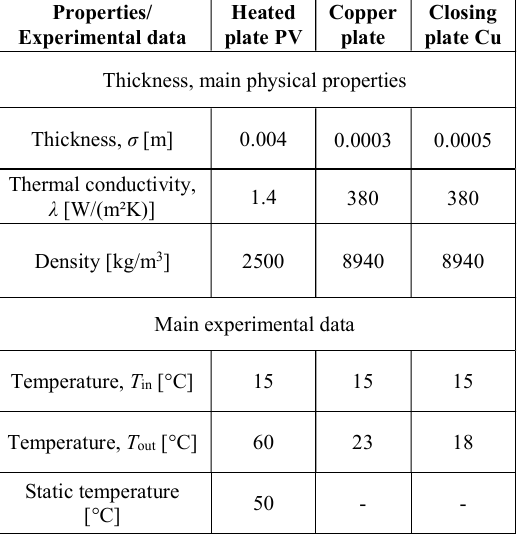
Table 1. Characteristics of the plates and experimental